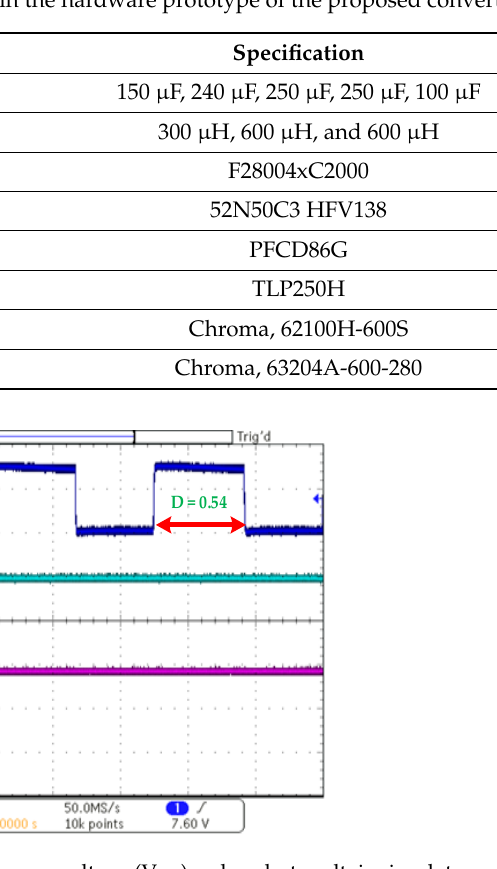
Figure 16. Experimental waveform for gate source voltage (V GS ), solar photovoltaic simulator output voltage (V PV ), and output voltage (V o ) for the proposed HVGSU converter at the 0.54 duty cycle (Hor: 20 µs/div).